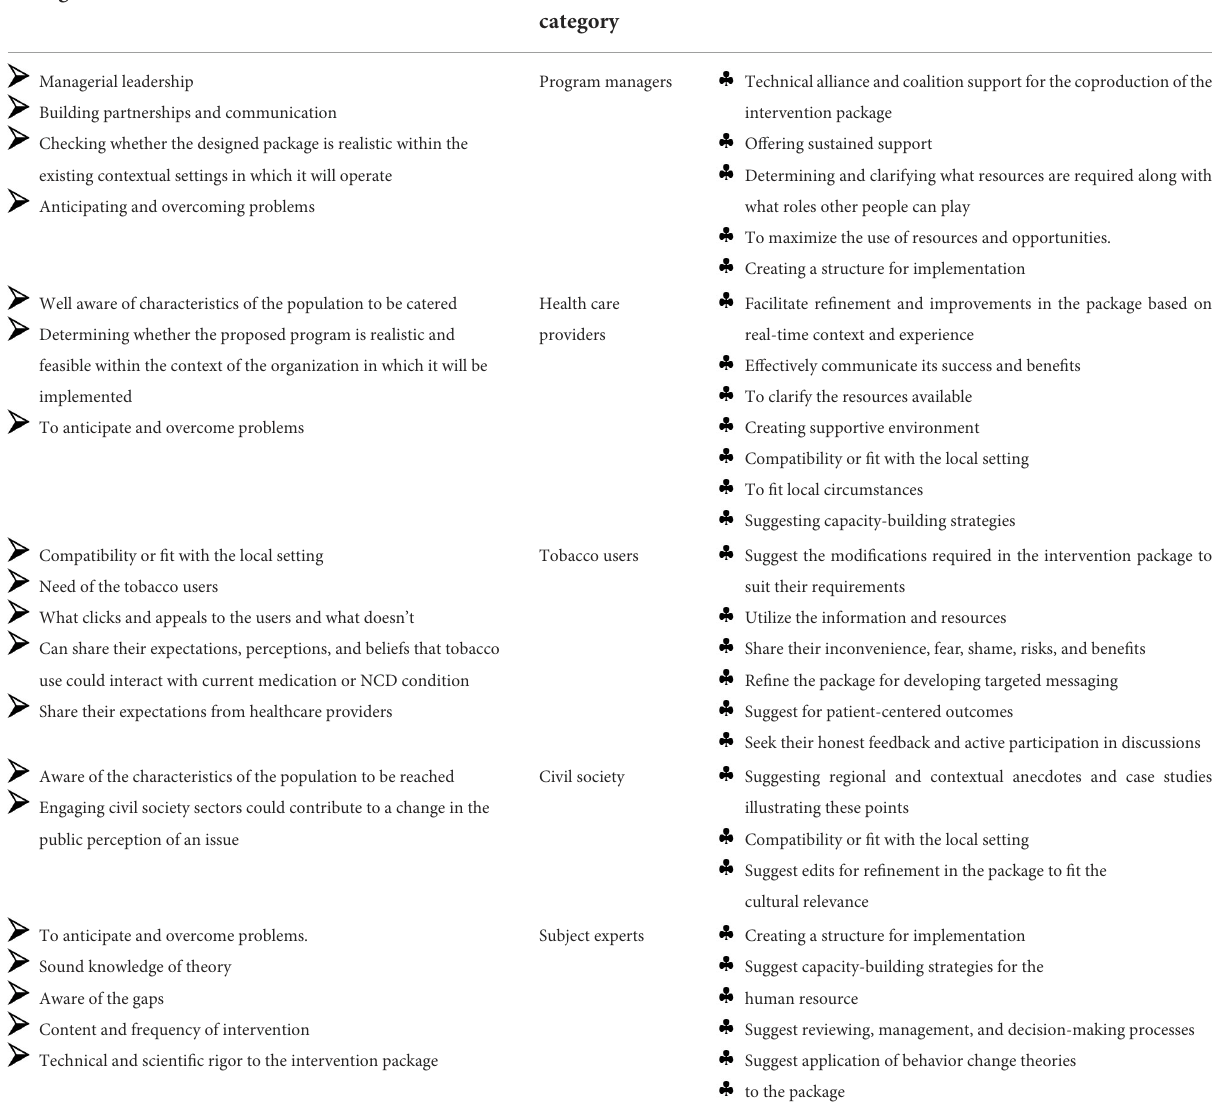
TABLE 1 Strengths and roles of relevant